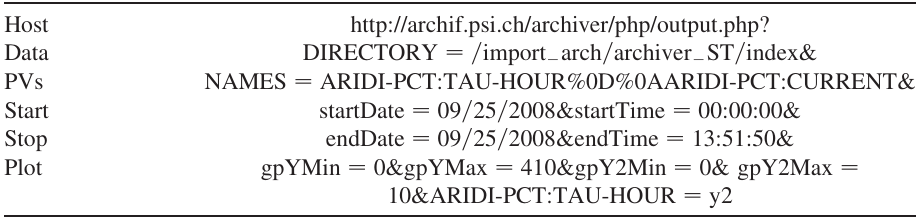
TABLE V. Example URL to the channel archive retriever.